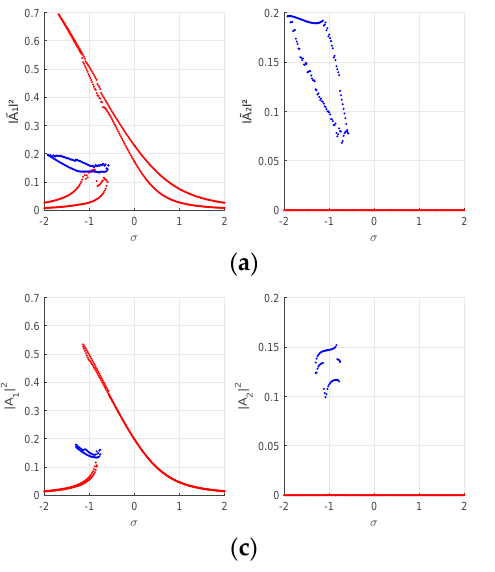
Figure 6. Envelopes of the amplitudes (cid:2038) (cid:3560) (cid:2869) and (cid:2038) (cid:2870) , of the pendulums physical responses computed, for ( a , b ) (cid:2012) (cid:3039) = 5% and ( c , d ) (cid:2012) (cid:3039) = 5% , using the LHS and gPCE methods, respectively.